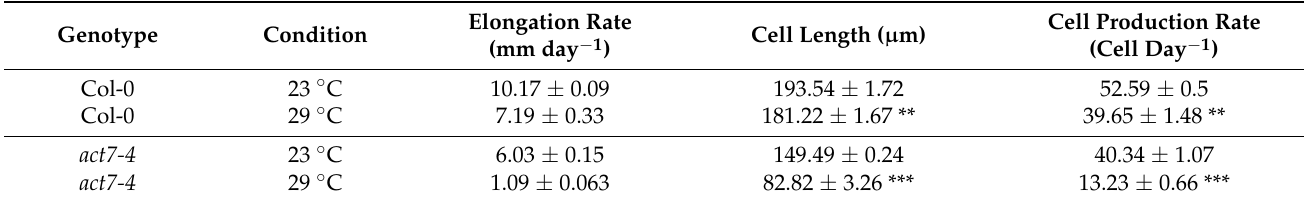
Table 1. Effect of moderate-high temperature stress on cell length and cell production rate in Col-0 and act7-4 mutant.